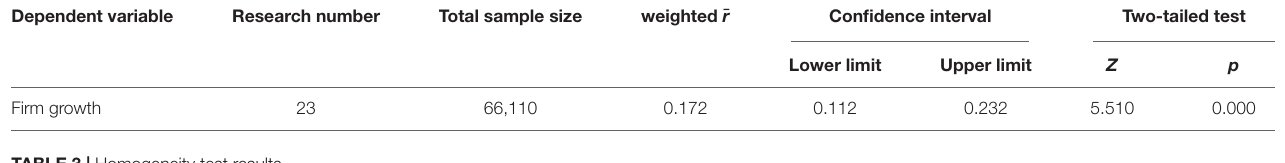
TABLE 3 | Homogeneity test